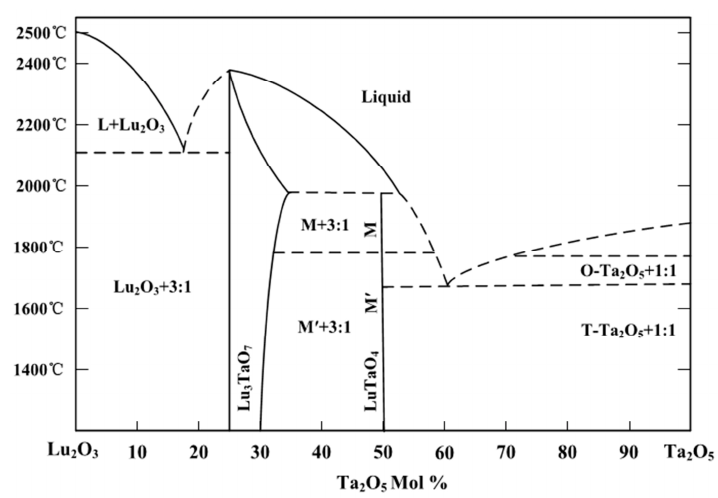
Figure 4. Phase-relation diagram of the Lu 2 O 3 –Ta 2 O 5 system [33]. Reproduced with permission